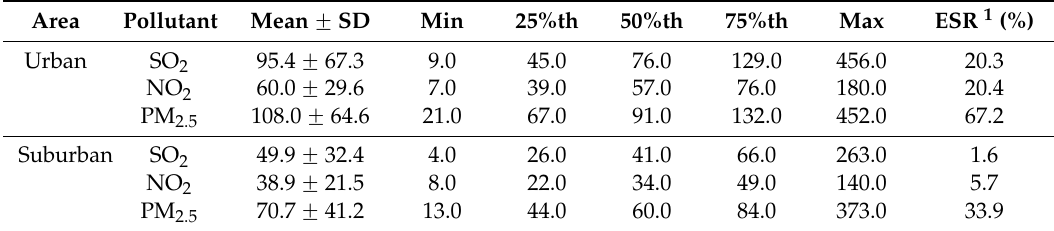
Table 1. Summary of daily air pollutants during 2013–2014 ( µ g/m 3 ).